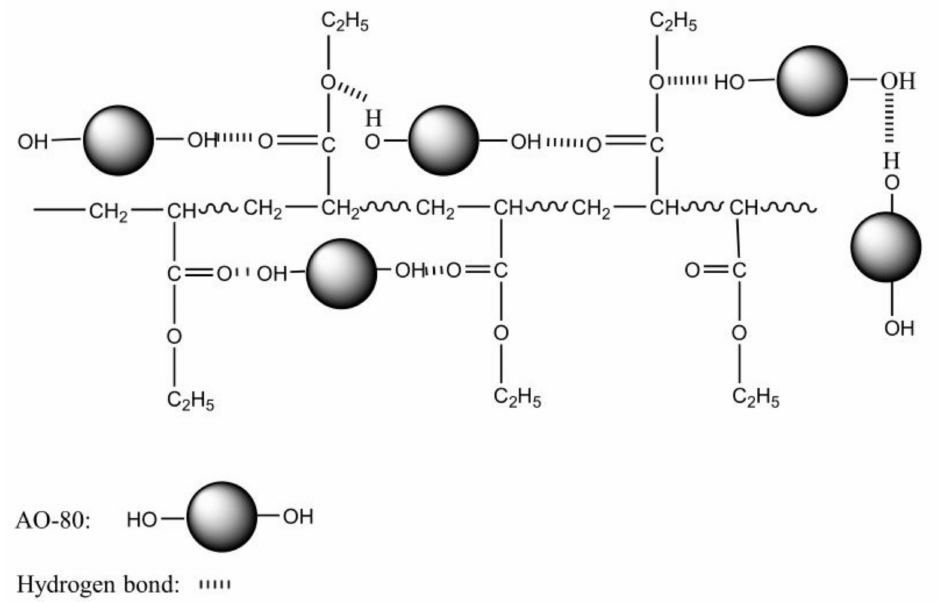
Figure 4. Possible hydrogen bond between AO-80 and ACM.